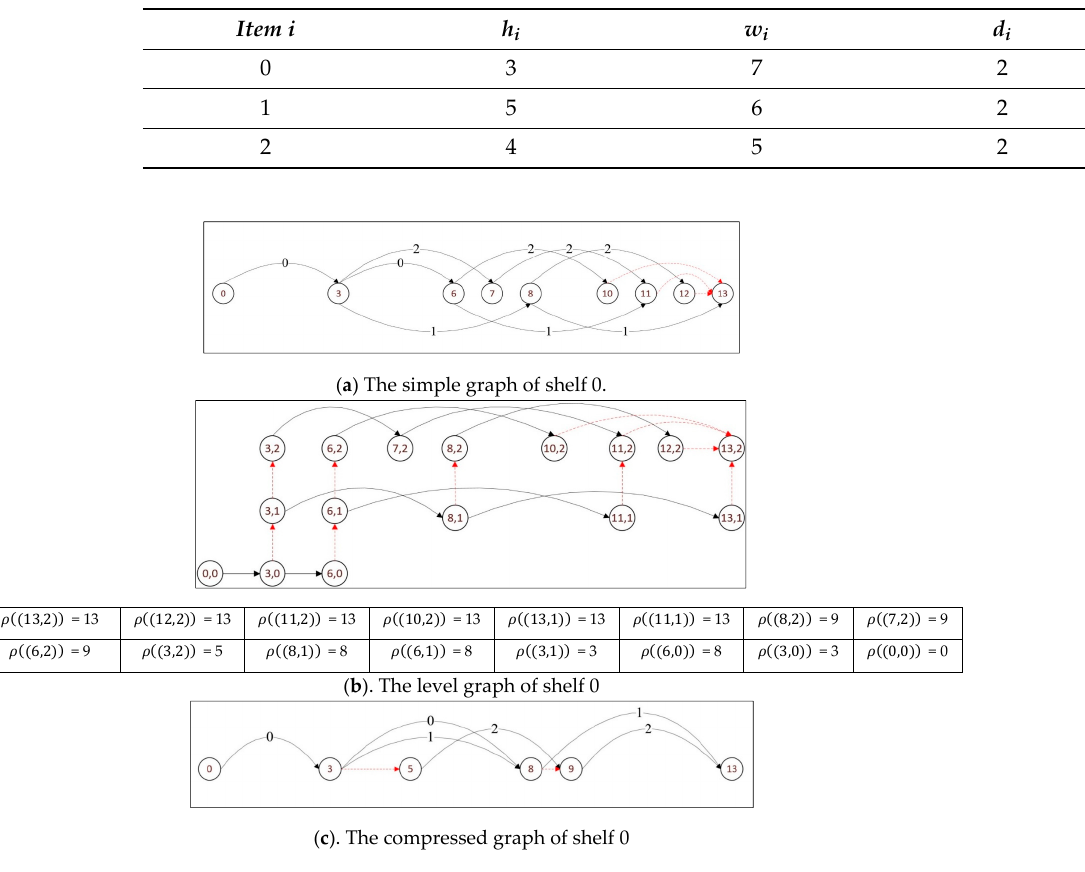
Processes 2023 , 11, x FOR PEER REVIEW Figure 6. The three graphs of shelf 0. Figure 6. The three graphs of shelf 0.